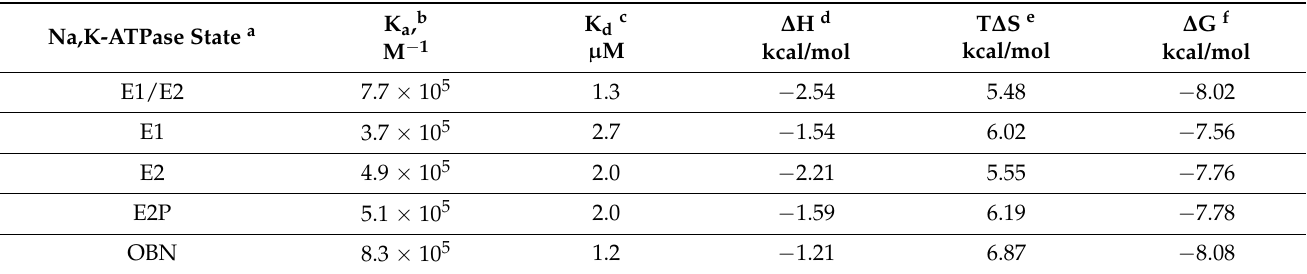
Table 2. Thermodynamic parameters of A β 42 binding to different conformations of Na,K-ATPase at 25 ◦